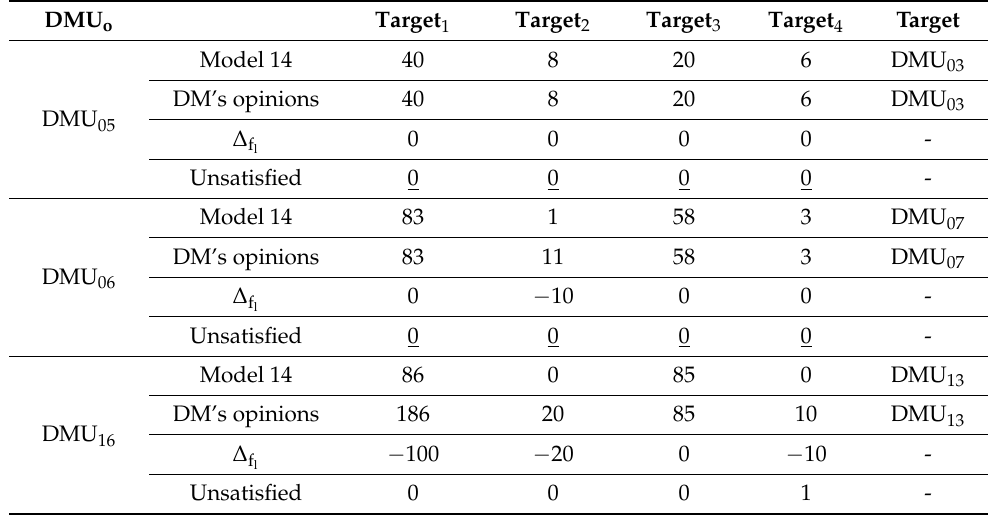
Table 6. The results of solving model 14 (Step 1 of STEM for p = 1) and DM’s opinions about them for three DMUs (related to the second interactive stage) in the first case